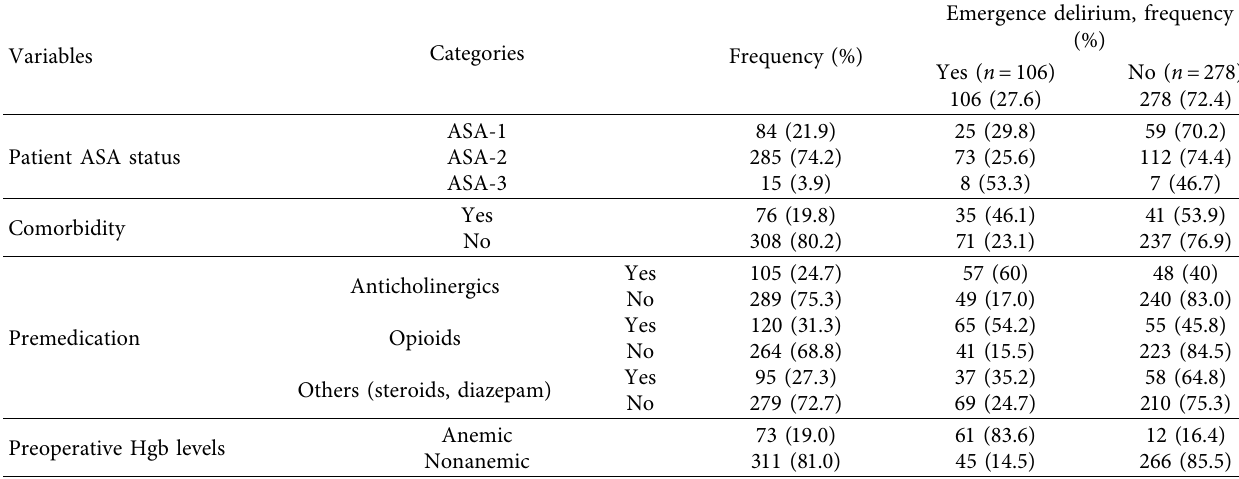
Table 1: A cross-tabulation of the preoperative factors in older patients who underwent elective surgery in the teaching hospitals of Ethiopia, Ethiopia ( n � 384).